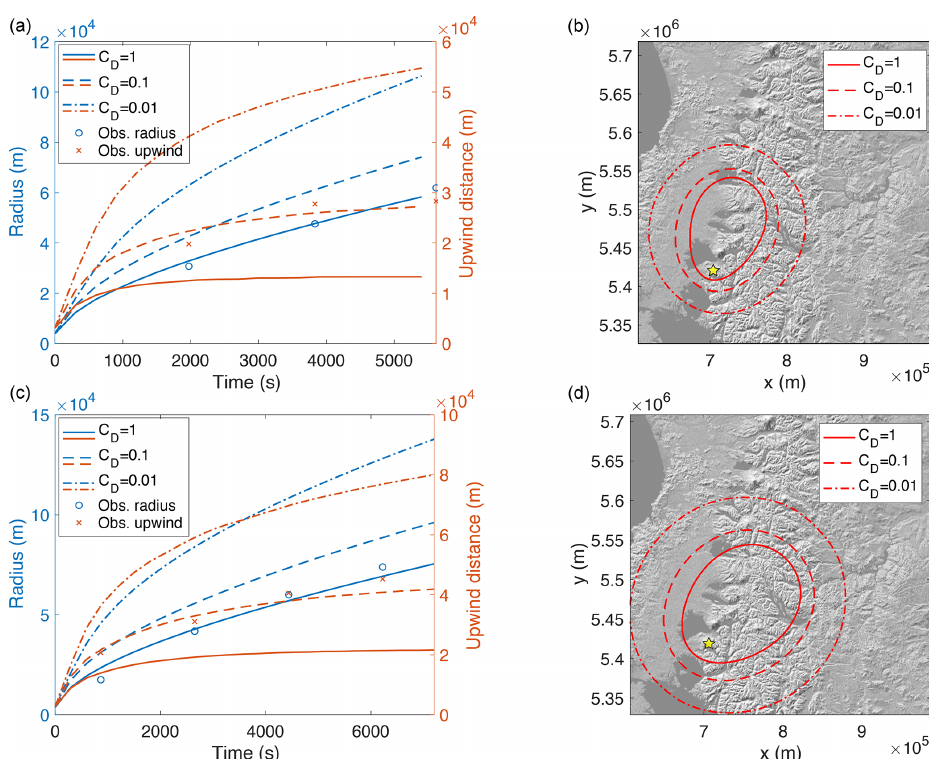
Figure 7. Umbrella cloud spreading for the two initial phases of the April 2015 Calbuco eruption. Panels (a, b) refer to the first phase, while the bottom panels refer to the second phase. Panels (a, c) are plotted the umbrella equivalent radius and the upwind distance versus time, with the markers representing the observations; (b, d) the umbrella cloud edges at the end of the simulations are shown. In all the panels, different lines (solid, dashed, and dash-dotted) represent the three different values of C D used in this